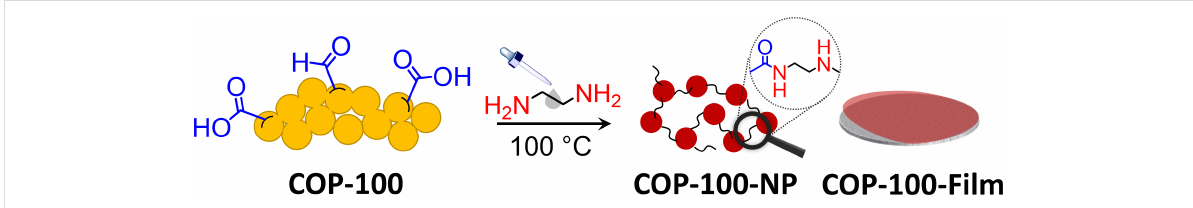
Figure 1: Schematic illustration of processible COP-100 in EDA to form either nanoparticles (COP-100-NP) or films (COP-100-Film) at 100 °C. The terminal groups of carboxylic acids and unreacted aldehydes are responsible for interparticle